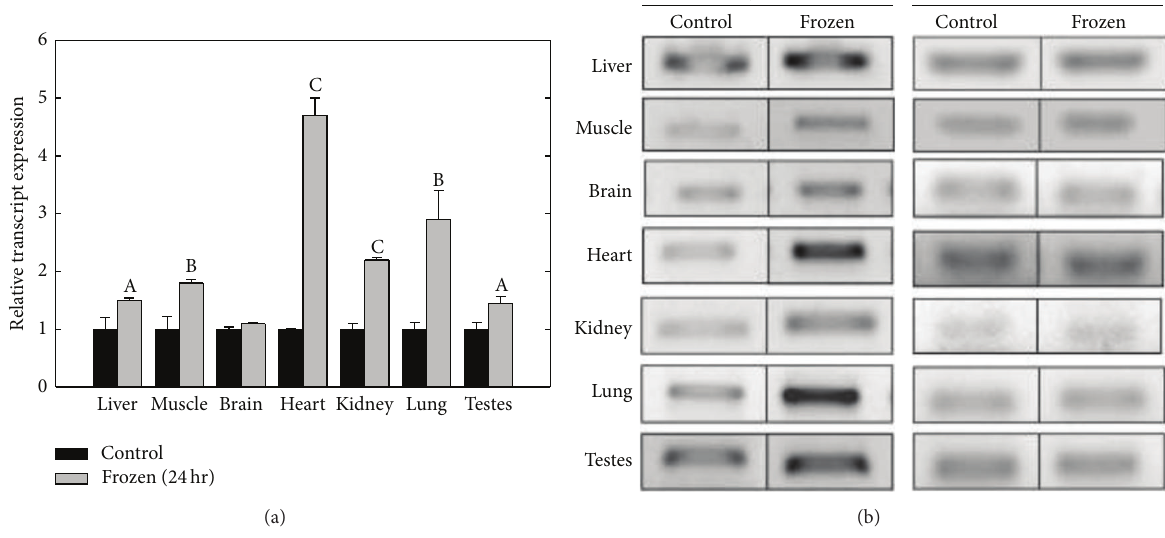
Figure 3: Relative fr47 transcript expression in response to 24 hr freezing. RT-PCR analysis showing the effects of 24hr freezing on fr47 mRNA transcript levels in select tissues of the wood frog. (a) Histogram shows mean values ( ± SEM, 𝑛 = 4 -5 independent determinations) for fr47 . (b) Representative fr47 and 𝛼 - tubulin bands used for quantification. Data were analyzed using analysis of variance with a post hoc Student-Newman-Keuls test where the letters “A” ( 𝑃 < 0.05 ), “B” ( 𝑃 < 0.01 ), and “C” ( 𝑃 < 0.005 ) represent significant differences between indicated stress and control.